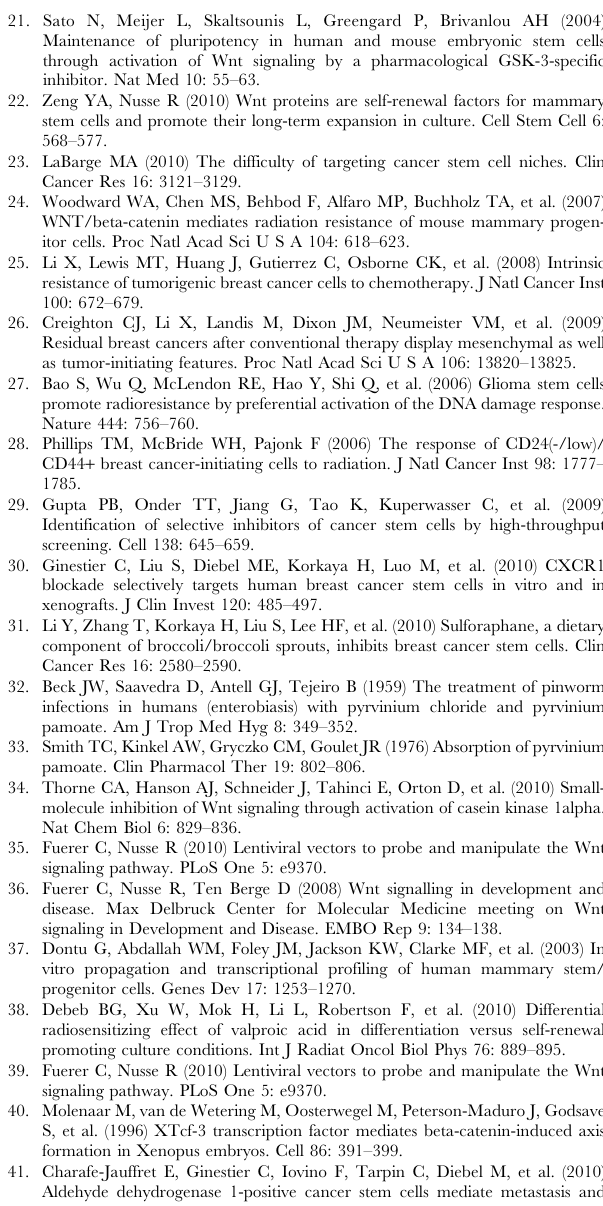
Figure S3 PP might decrease lung metastasis in a mouse tumors 505 model. Mouse tumor 505 chunks were implanted into